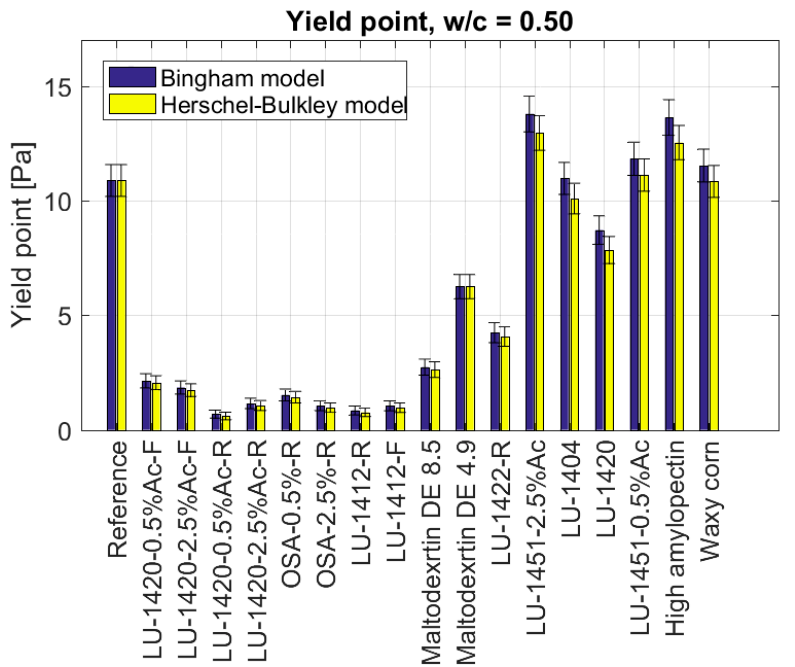
Figure 2. Yield points of cement slurries, depending on the type of admixture in the form of modified starch for w/c = 0.50 starch admixtures used.